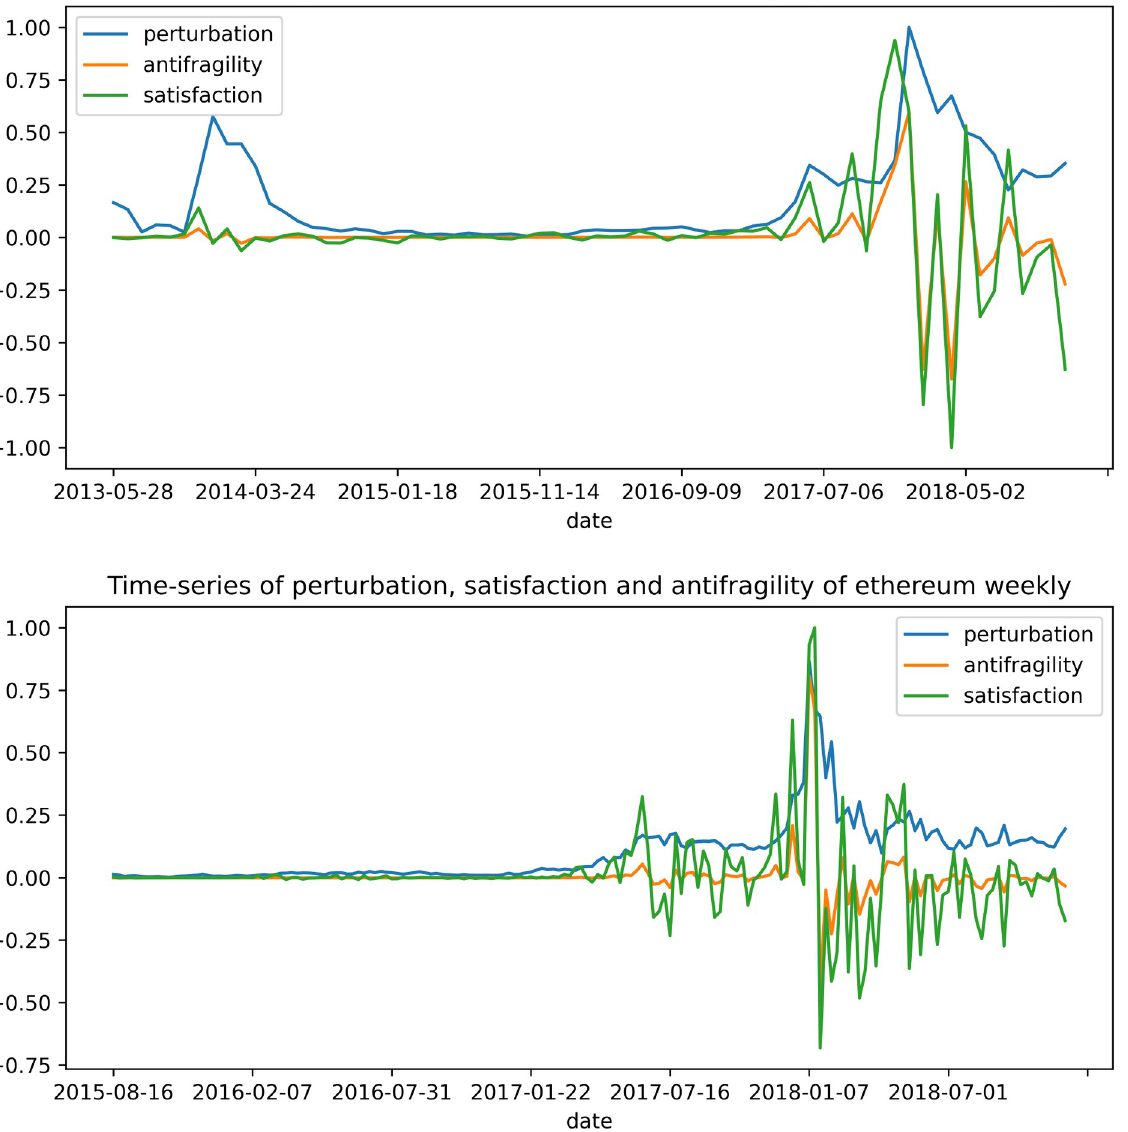
Fig 1. Time-series of the values of perturbation, satisfaction and anti-fragility of ethereum and bitcoin cryptocurrencies in weekly and monthly intervals, respectively. Notice that the time intervals are different. We calculated the satisfaction (price return) using Eq (1) for the discrete time i = 1 , 2 , ... , N ; and the antifragility using Eq (2). For the perturbation in Eq (2) we use the average quantity for cryptocurrencies given by Eq (16). We plot this perturbation as a third